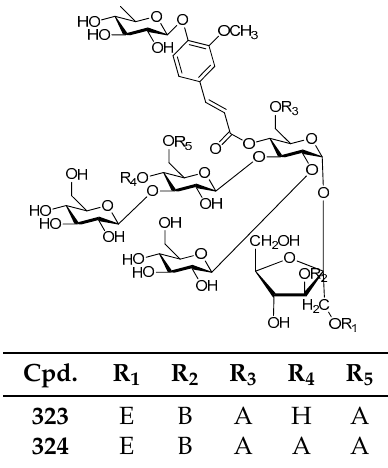
Figure 66. Structures of compounds 323 – 324 .